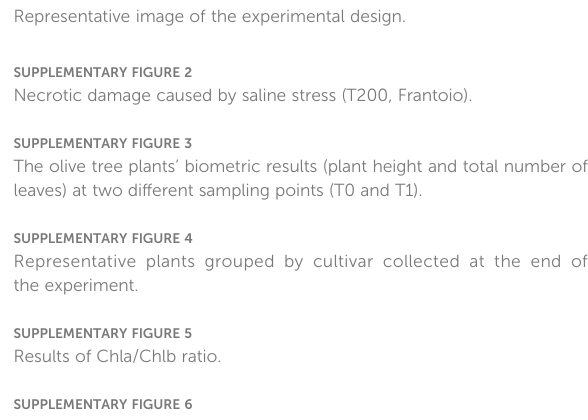
SUPPLEMENTARY FIGURE 2 Necrotic damage caused by saline stress (T200, Frantoio). SUPPLEMENTARY FIGURE 3 The olive tree plants ’ biometric results (plant height and total number of leaves) at two different sampling points (T0 and T1). SUPPLEMENTARY FIGURE 4 Representative plants grouped by cultivar collected at the end of the experiment. SUPPLEMENTARY FIGURE 5 Results of Chla/Chlb ratio. SUPPLEMENTARY FIGURE 6 Results of rarefaction on samples grouped according to cultivar. Curves are getting before (A) and after (B) rarefaction processes. The horizontal axis indicates the sequences resulting from the Illumina MiSeq sequencing platform on V3-V4 regions. The vertical axis shows the number of ampli fi ed sequence variants (ASVs). SUPPLEMENTARY FIGURE 7 ASV circle computed on samples classi fi ed based on (A) treatment and (B) cultivar. Min_prop_tax parameter = 0.005, data computed at Family level. SUPPLEMENTARY FIGURE 8 Data ordination using different multivariate methods. CCA, canonical correspondence analysis; DCA, Detrended correspondence analysis; DPCoA, Double Principle Coordinate Analysis; NMDS, Non-metric multidimensional scaling; PCoA, Principal Coordinate Analysis; RDA, Redundancy analysis. SUPPLEMENTARY FIGURE 9 The classi fi cation of cumulative error rates by Random Forest (Liaw et al., 2002). The overall error rate is shown as the black line; the red and green lines represent the error rates for each class. Random forest is an